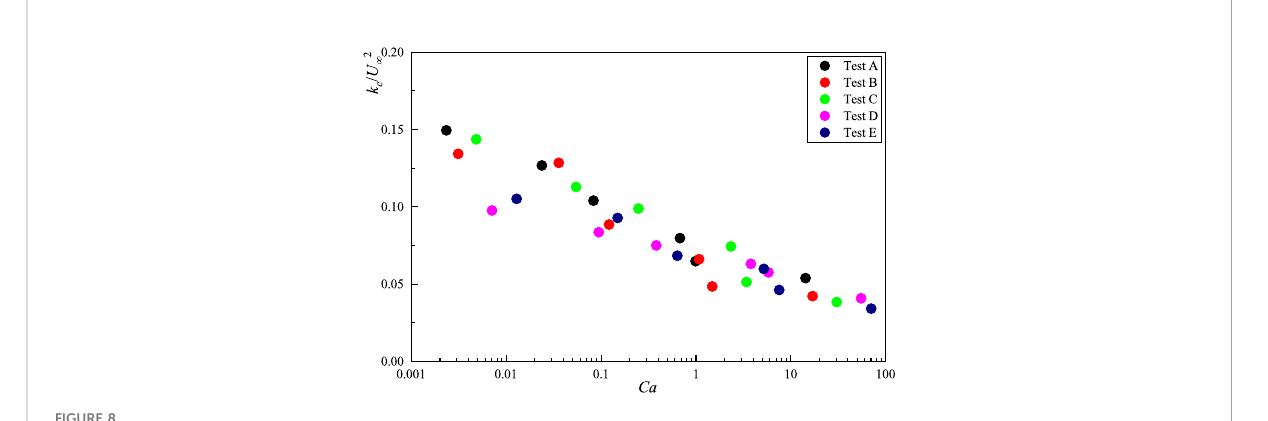
FIGURE 8 The relationship between canopy-averaged turbulent kinetic energy, k c = U 2 ∞ , and the Cauchy number of the vegetation canopy, Ca .